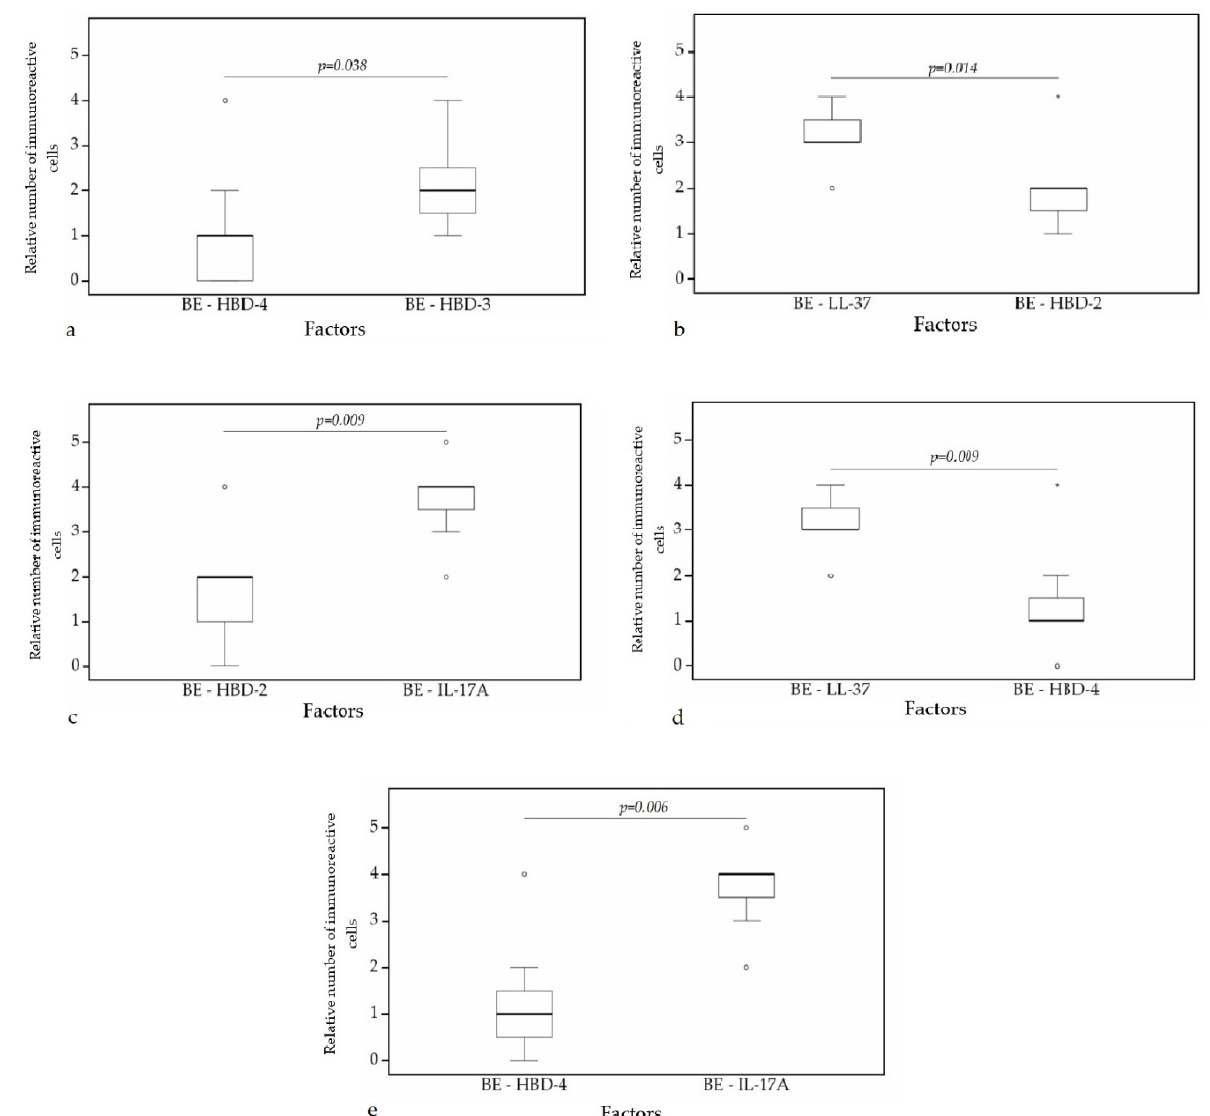
Figure 11. Wilcoxon test revealing statistically significant difference between the relative numbers of different factors in bronchial epithelium. ( a ) A statistically significant difference between HBD-4 and HBD-3 in bronchial epithelium. ( b ) A statistically significant difference between HBD-2 and LL-37 in bronchial epithelium. ( c ) A statistically significant difference between HBD-2 and IL-17A in bronchial epithelium. ( d ) A statistically significant difference between LL-37 and HBD-4 in bronchial epithelium. ( e ) A statistically significant difference between HBD-4 and IL-17A in bronchial epithelium. BE, bronchial epithelium; HBD-2, human β defensin 2; HBD-3, human β defensin 3; HBD-4, human β defensin 4; LL-37, cathelicidine; IL-17A, interleukin 17A; o—outlier data—indicates a higher or lower number of relative positive cells which lie more than 1.5 but less than 3.0 times the interquartile range below the first quartile or above the third quartile; *—extreme outlier data—indicates a higher or lower number of relative positive cells which lie more than 3.0 times the interquartile range below the first quartile or above the third quartile.